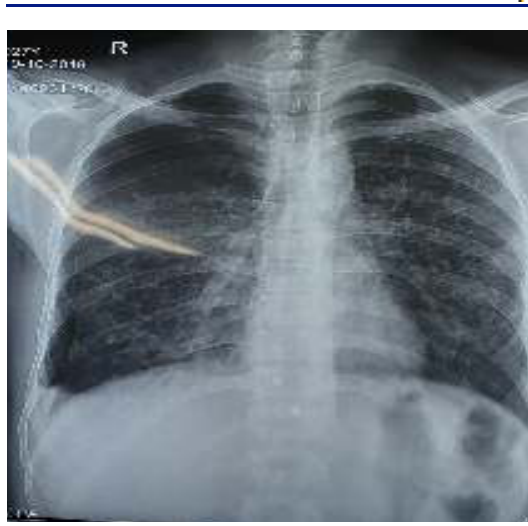
Figure 1: A chest-X-ray showing a bilateral multiple cystic lesions in both lung fields with right-sided pneumothorax